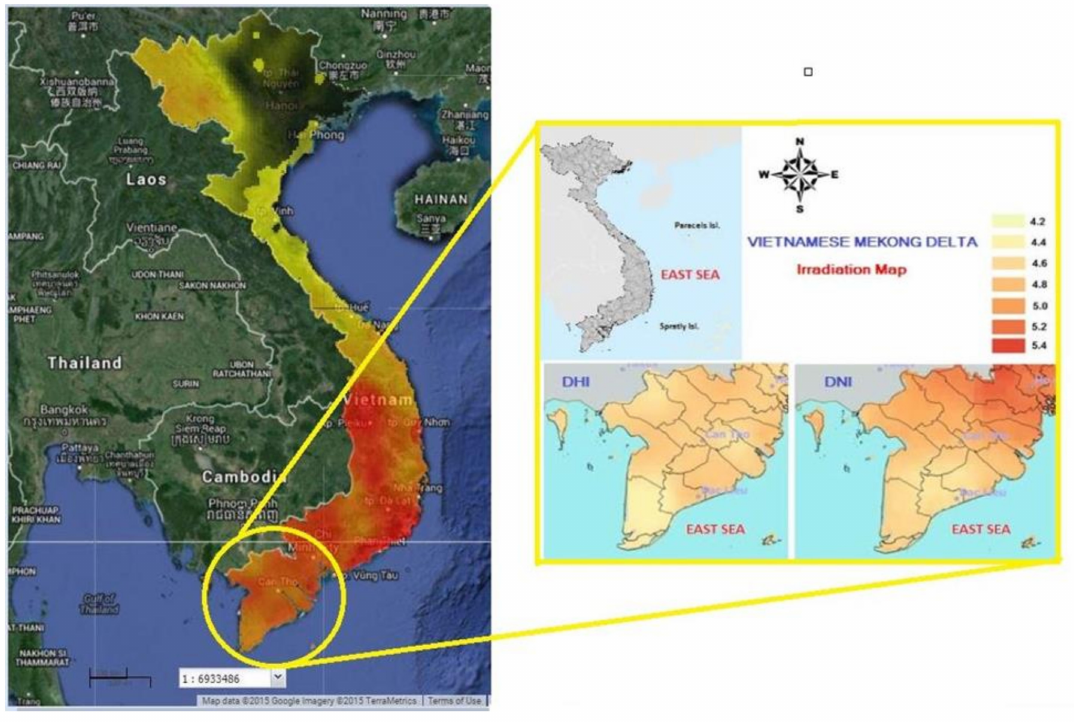
Figure 6. Irradiation Map of Mekong Delta, Vietnam